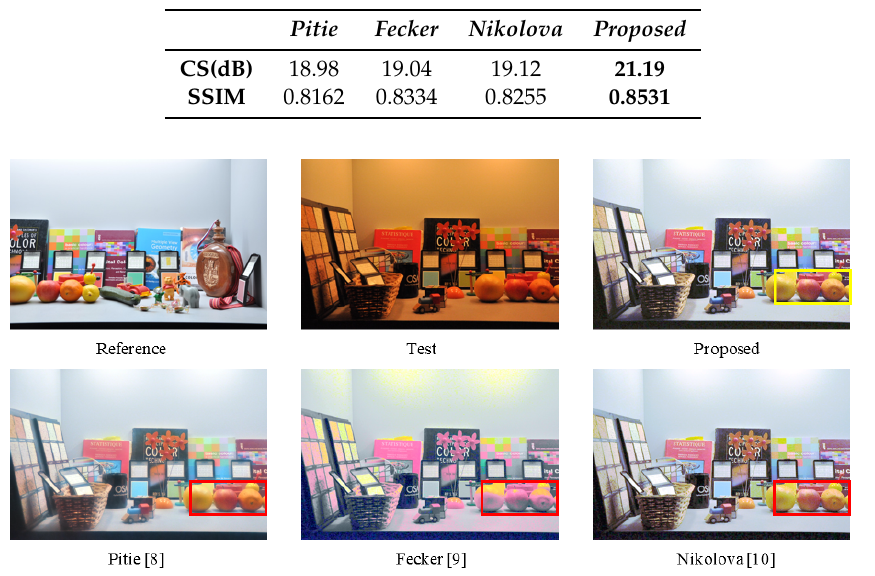
Figure 9. Comparison for the real image pair. Image Source: courtesy of the authors and databases referred on [29].